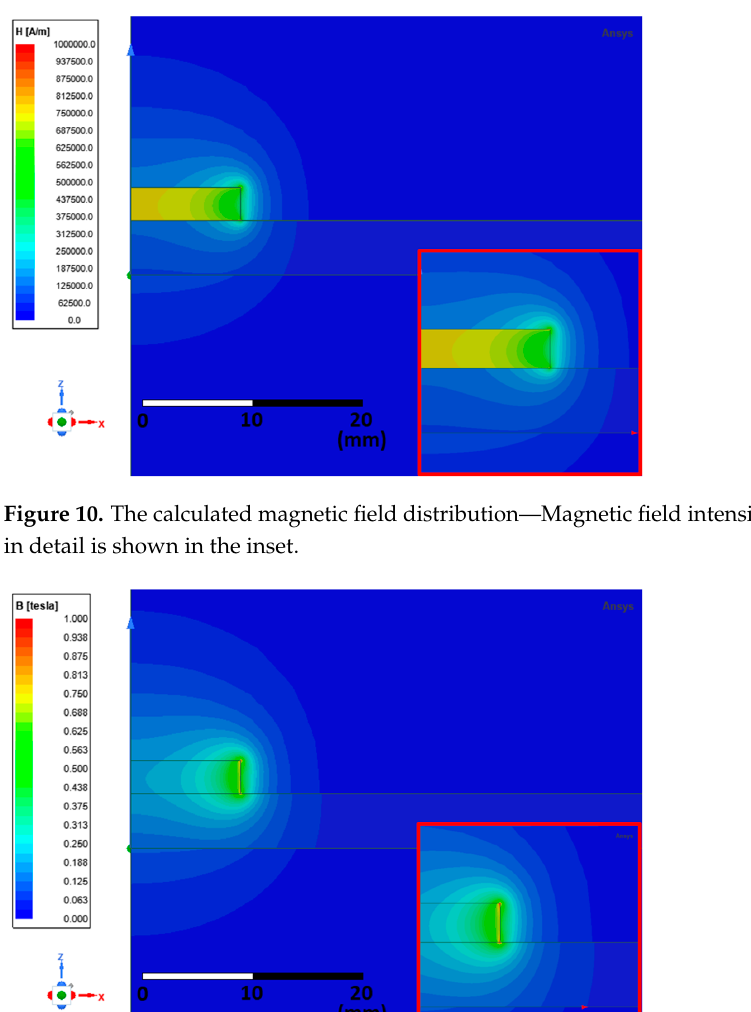
9 of 13 Figure 9. An image of a computer network model.